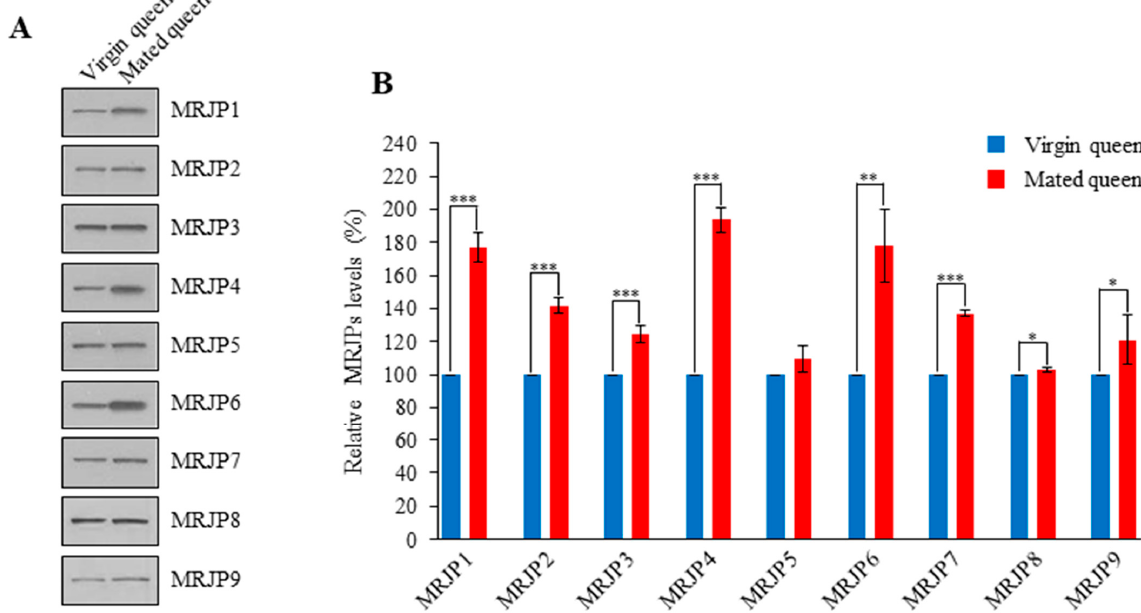
Figure 8. Detection of MRJPs in the spermathecal fluid of virgin and mated queens. ( A ) The MRJPs in the spermathecal fluid of virgin and mated queens were detected using western blot analysis conducted with antibodies against MRJPs. ( B ) The levels of MRJPs are shown relative to their levels in the spermathecal fluid of virgin queens (shown as 100%). The bars represent the mean ± SD values. * p < 0.05, ** p < 0.01, and *** p < 0.001.